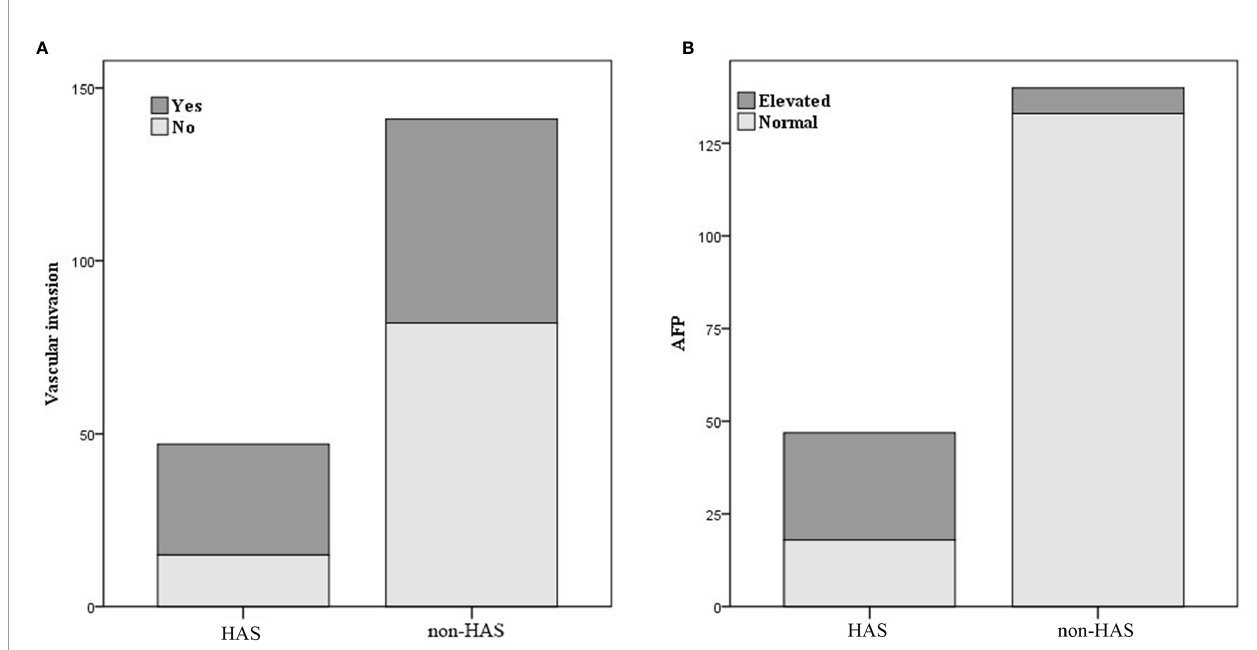
FIGURE 5 | Comparison of vascular invasion (A) and alpha-fetoprotein (AFP) level (B) between hepatoid adenocarcinoma of the stomach (HAS) and non-HAS cases.